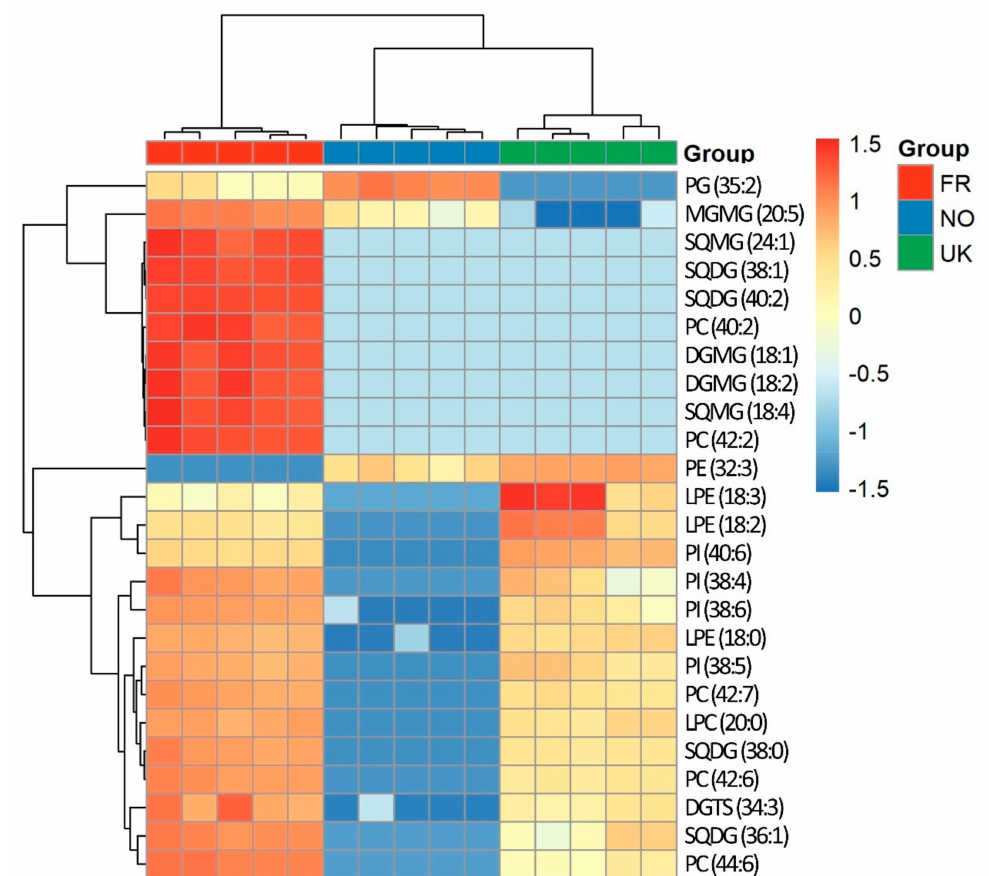
Figure 5. Two-dimensional hierarchical clustering heat map with the 25 most significant polar lipid discriminant species after Kruskal–Wallis statistical analysis. Levels of relative abundance are shown on the color scale, with numbers indicating the fold di ff erence from the mean. Abbreviations: FR—France, NO—Norway, UK—United Kingdom. Labels of the species are according to the notation AAAA (xx:i) (AAAA = lipid class; xx = total of carbon atoms in fatty acid; i = number of